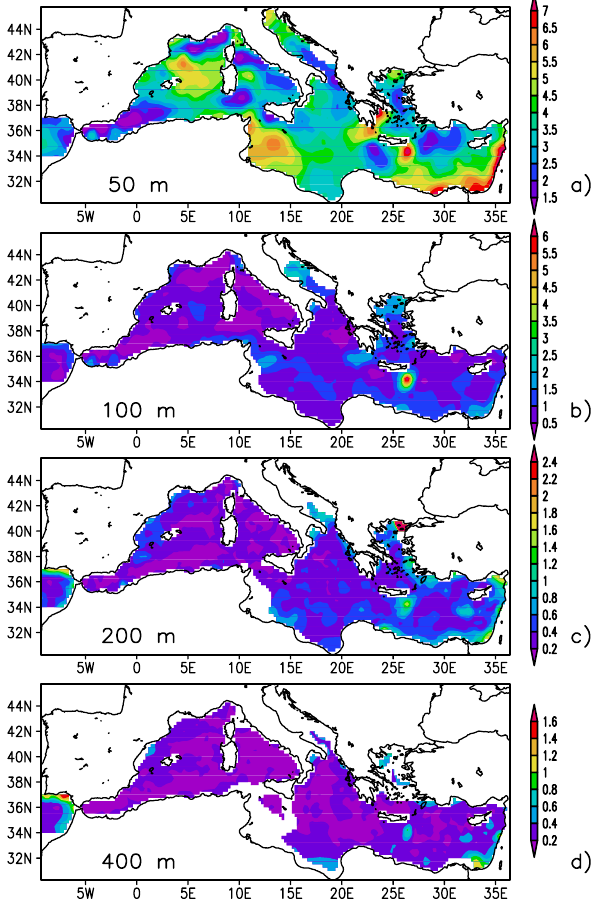
Fig. 7. Spatial distribution of sound speed standard deviation (m/s) at 50m (a) , 100m (b) , 200m (c) and 400m (d) .